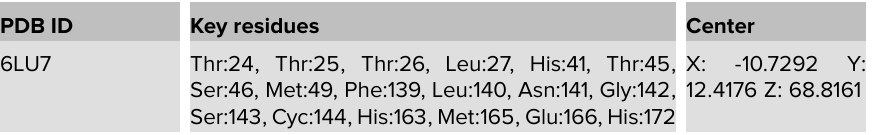
PDB ID Key residues Center